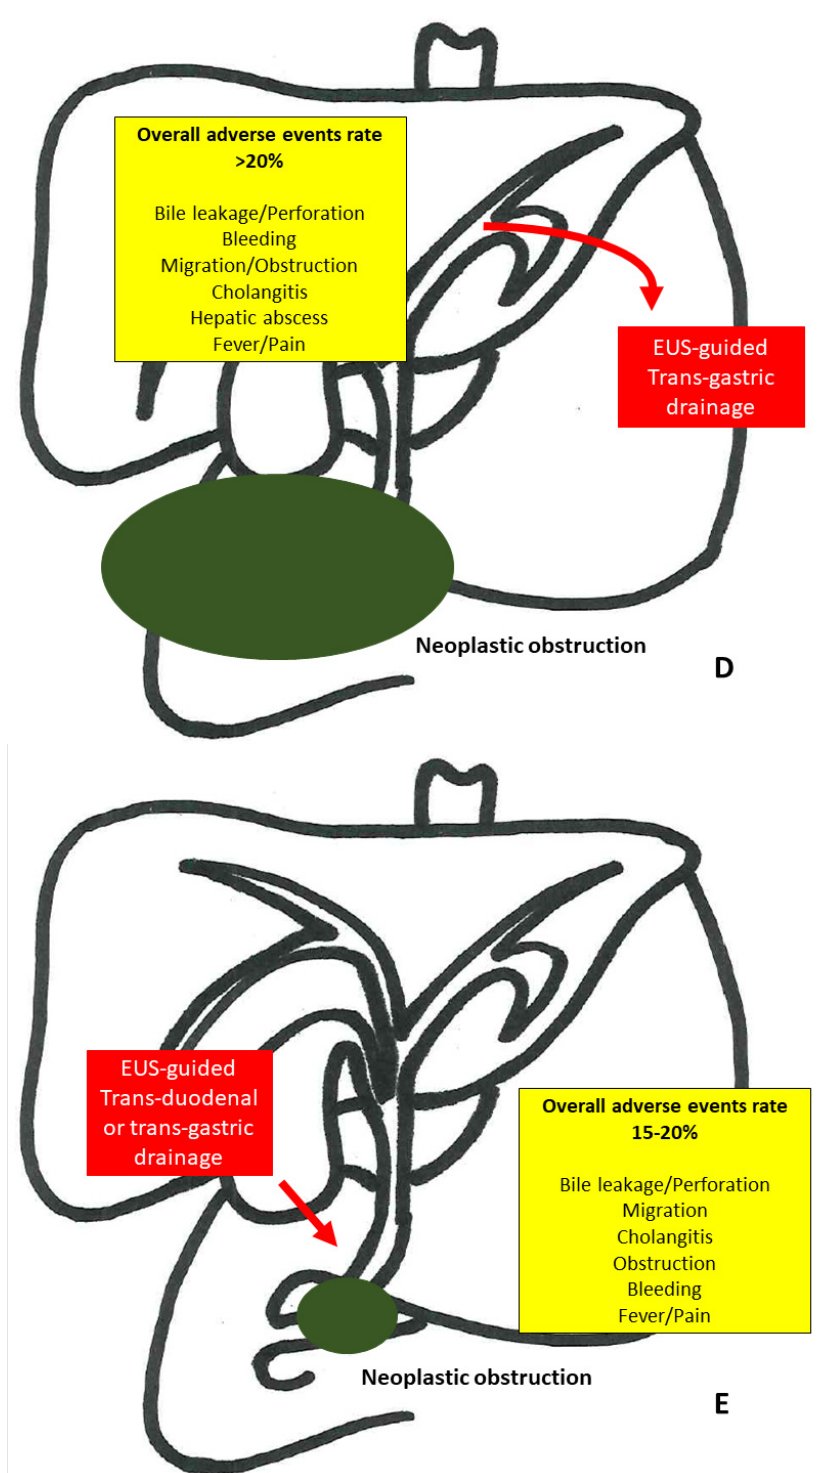
Figure 1. ( A ) Endoscopic Retrograde Cholangiopancreatography (ERCP); ( B ) EUS-Guided Ren- dezvous; ( C ) EUS-Guided Choledochoduodenostomy; ( D ) EUS-Guided Hepaticogastrostomy; ( E ) EUS-Guided Gallbladder Drainage.